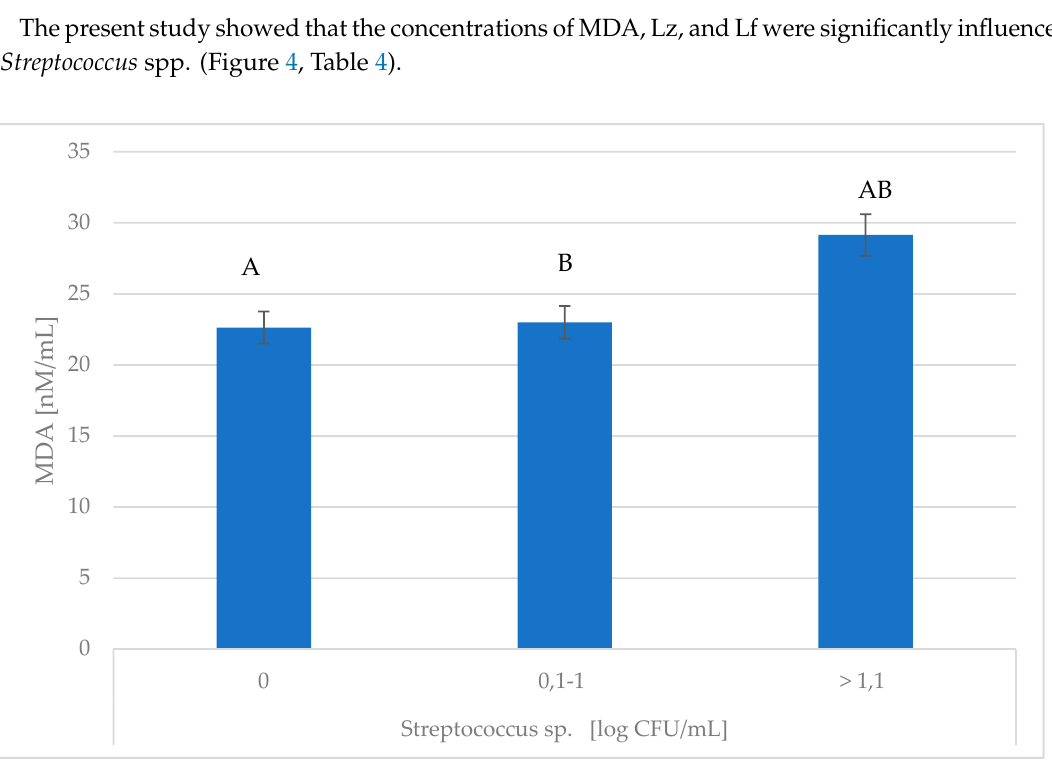
Figure 4. Association of Streptococcus spp. with changes in MDA content. MDA—di-malonic aldehyde; A,B Means with the same letters differ significantly at: capitals— p ≤ 0.01. Table 4. Association of Streptococcus spp. with changes in whey proteins and TAS content. Streptococcus spp.